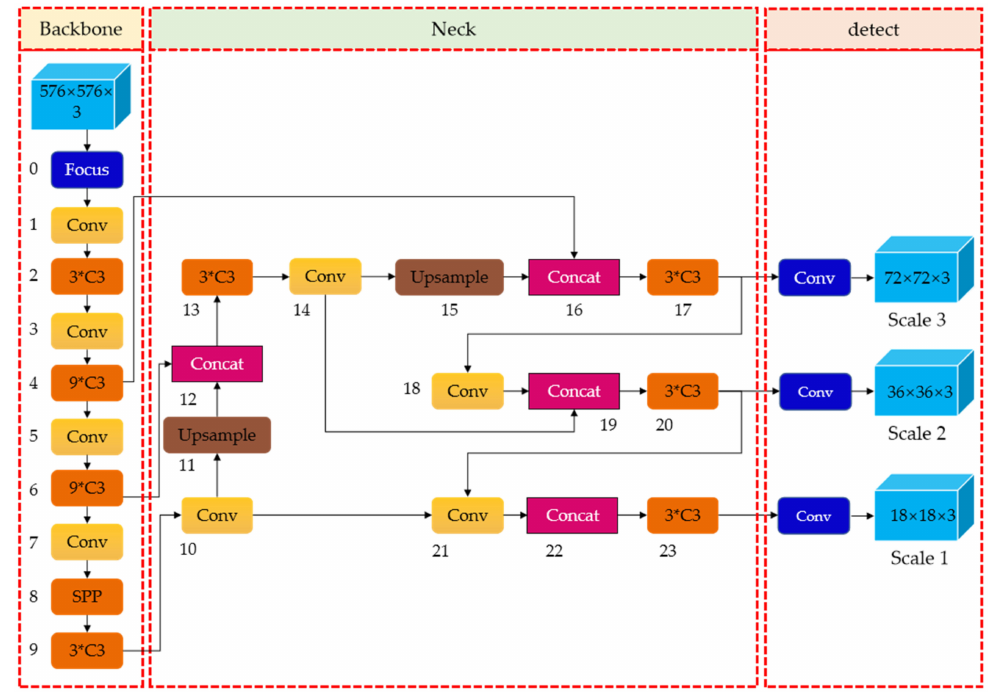
Figure 2. The architecture of the